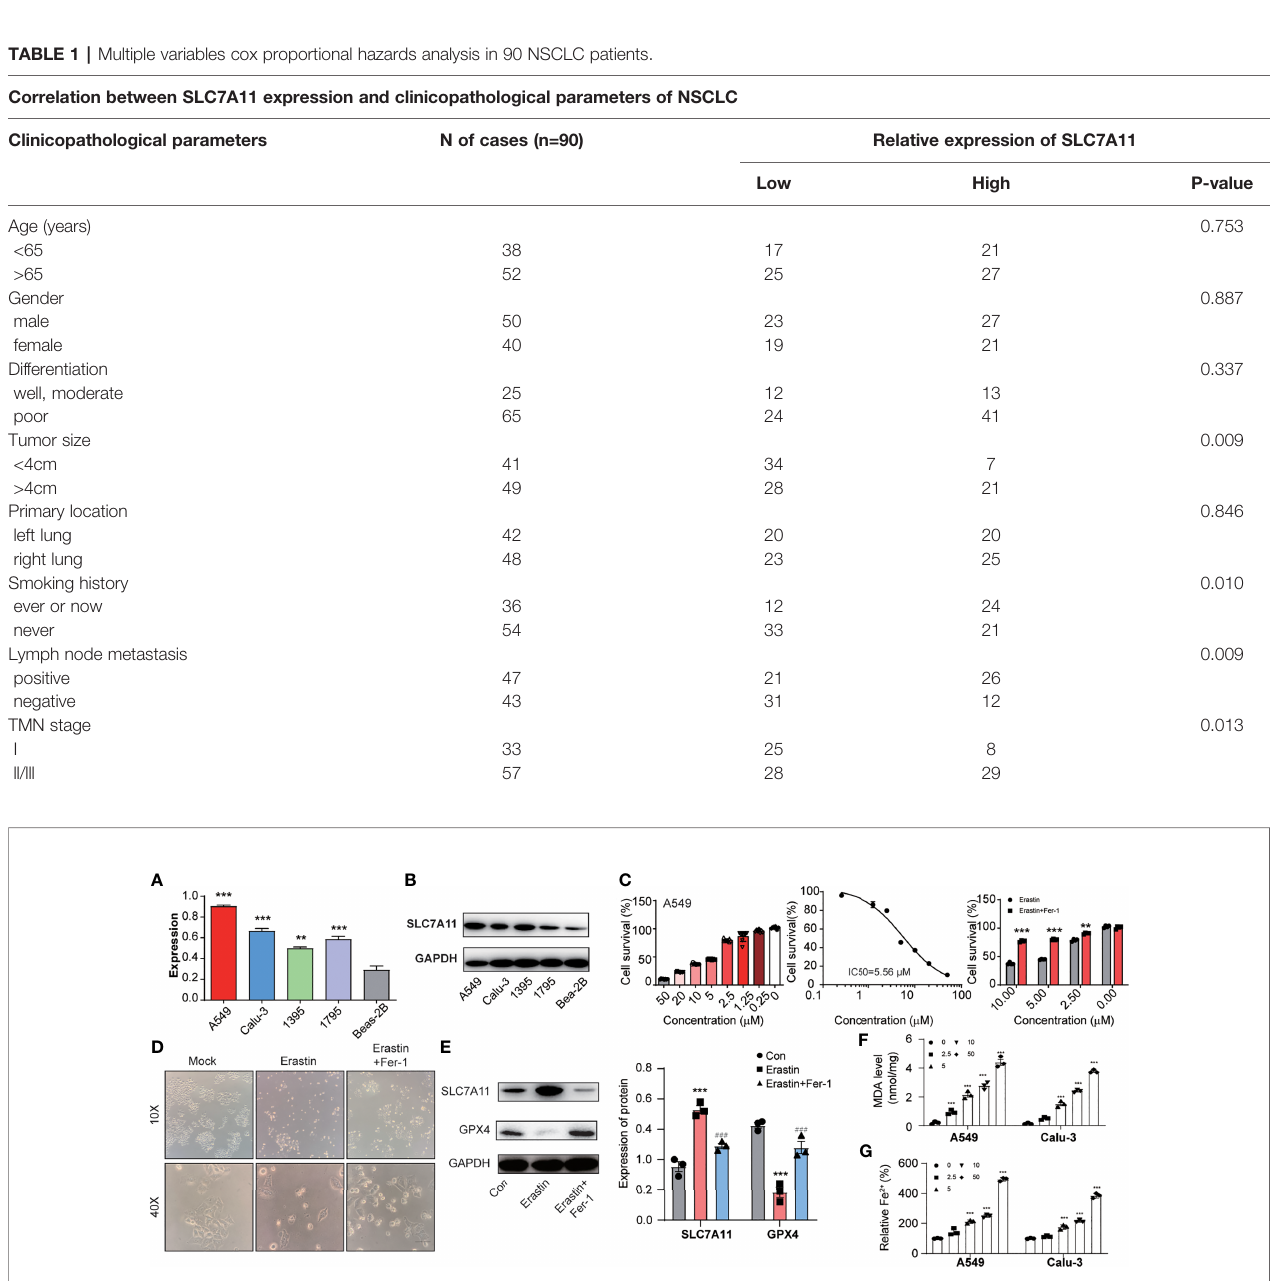
FIGURE 2 | The lung cancer cells with high expression of SLC7A11 could induce ferroptosis. (A) and (B) SLC7A11 expression level in different NSCLC cells. (C) CCK8 assay was used to detect cell survival levels of A549 induced by erastin and erastin plus ferrostatin-1 at different concentrations. (D) Images analysis of A549 cells after erastin and erastin plus ferrostatin-1 treatment. (E) Expression levels of SLC7A11 and GPX-4 after erastin and erastin plus ferrostatin-1 treatment. A549 cells with treatment of multiple concentrations of erastin for 24 h were subjected to analysis. [There was signi fi cant difference between con and Erastin (*** P < 0.001 ). There was signi fi cant difference between Erastin and Erastin+Fer-1 ( ### P < 0.001 )]. The lipid formation levels (F) and intracellular Fe 2+ accumulation levels (G) on A549 and Calu-3 cells during the erastin induced ferroptosis progress. **P < 0.01 and ***P < 0.001